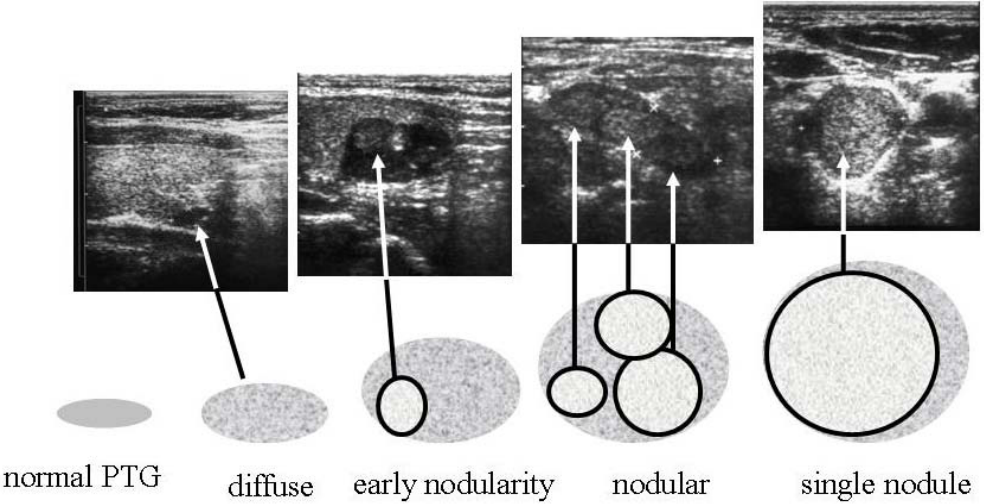
FIGURE 2 . Progression of renal hyperparathyroidism. Normal PTGs are not visible with ultrasound. Hyperplastic glands with diffuse hyperplasia are hypoechogenic, with homogeneous echoes. Early nodularity is represented with a small isoechogenic nodule within the enlarged hypoechogenic gland. The next step is multiple nodules in the PTG. The end step of development of nodularity is one nodule that takes over the whole gland.